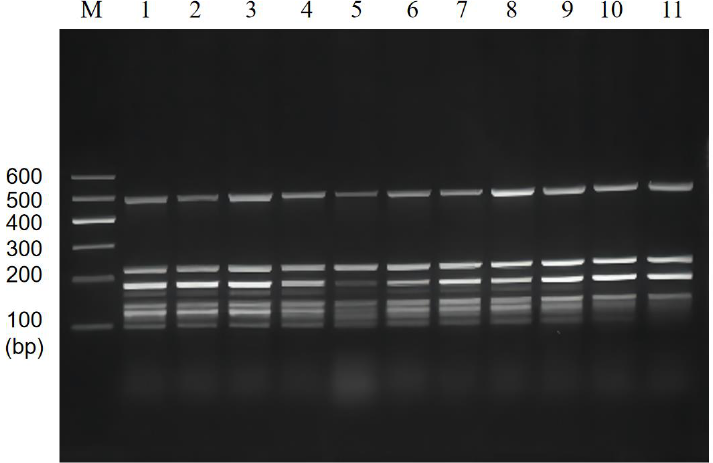
Figure 2. Multiplex PCR amplification at the different annealing temperatures. Lane M: DNA marker B 600; Lane 1~11: Annealing temperature is 48 °C, 49 °C, 50 °C, 51 °C, 52 °C, 53 °C, 54 °C, 55 °C, 56 °C, 57 °C, and 58 °C, respectively.